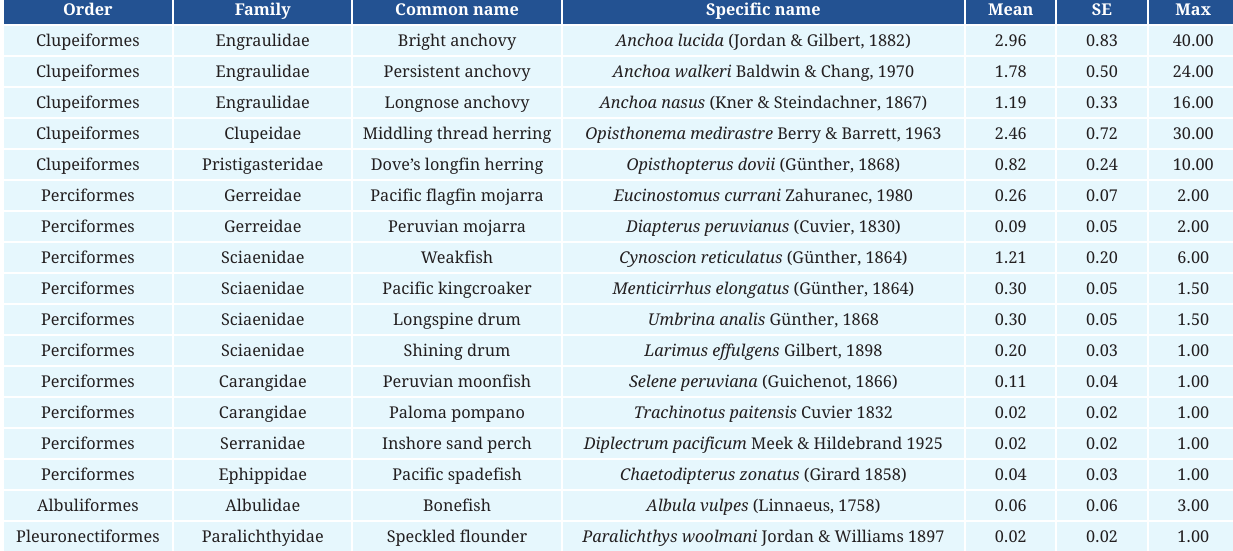
TABLE 1 | Abundance (individuals m -3 ) for each species in the whole study. Max, maximum value reached for each species in a simple; Mean, mean value; SE, standard